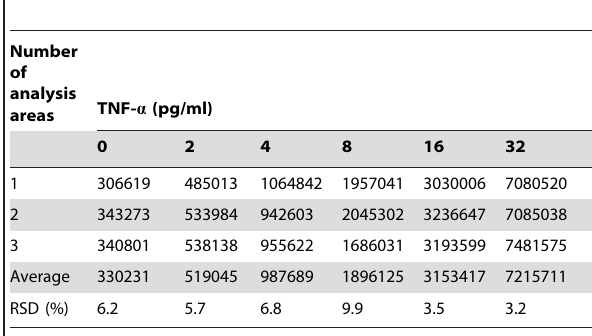
Table 2. Reproducibility of luminescence intensity of TNF- a in 1 channel